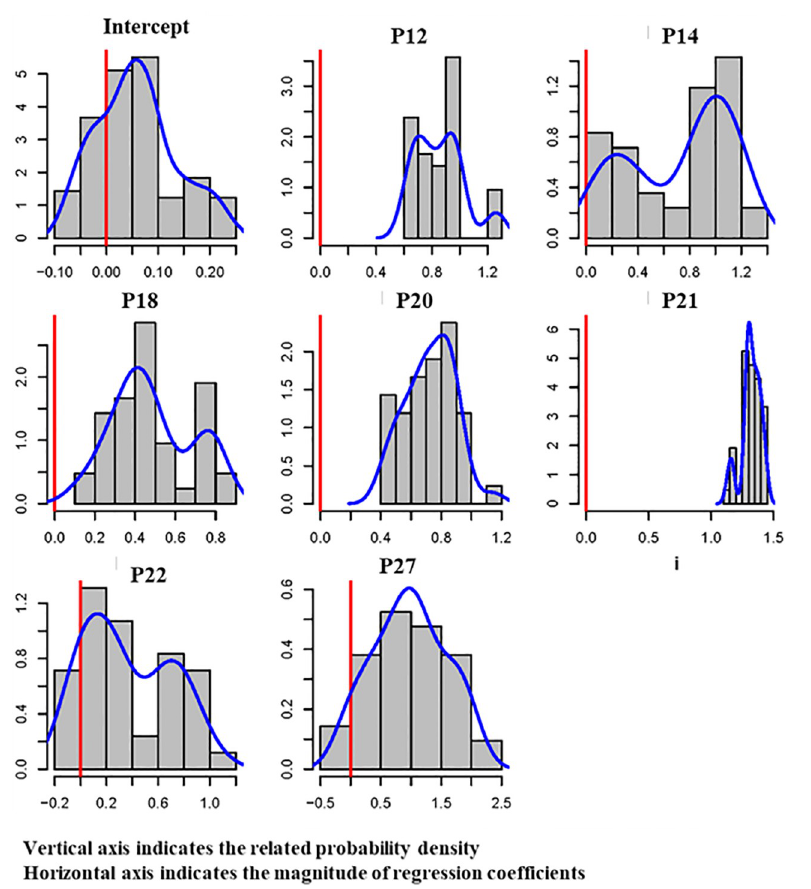
Fig 6. Schematic results of EBA for reconstruction cost performance predictors.